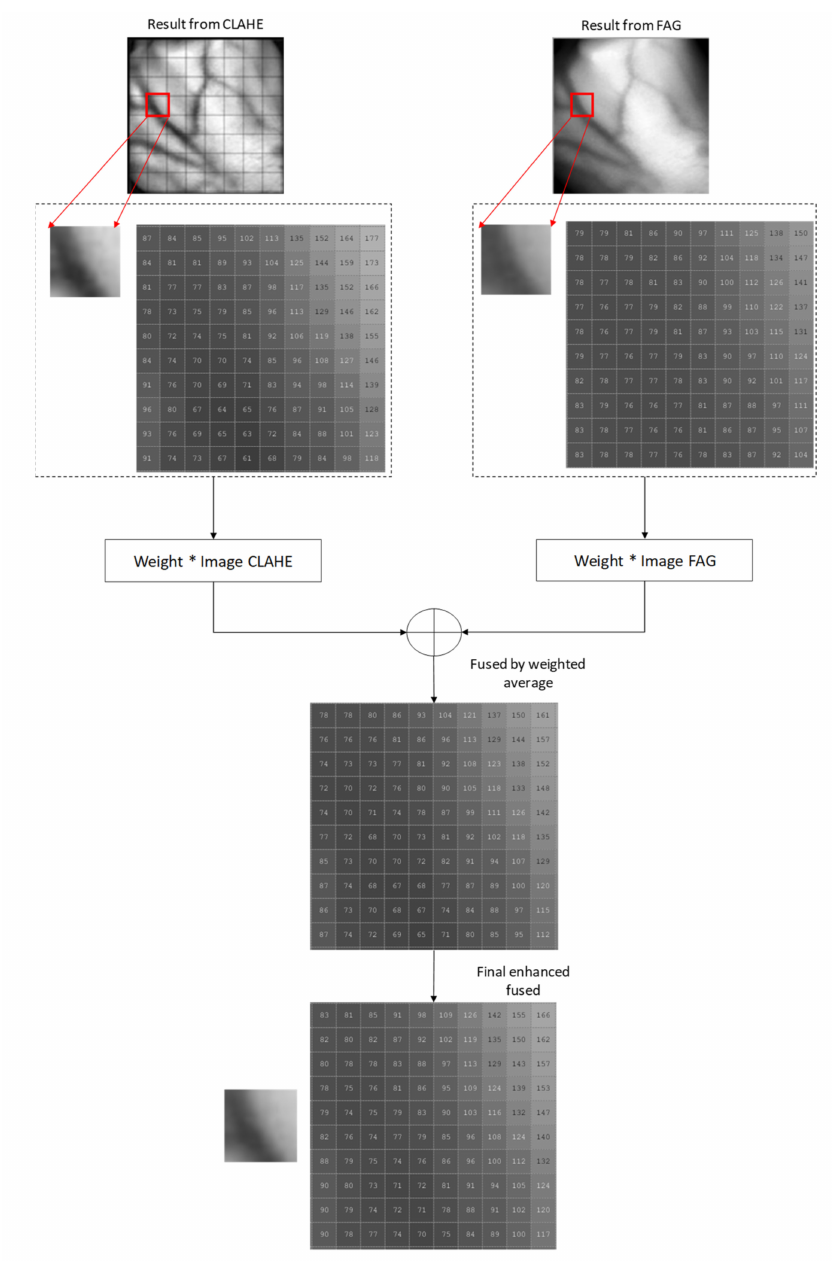
Figure 4. The proposed improved weighted average fusion flow diagram on a small part of vein